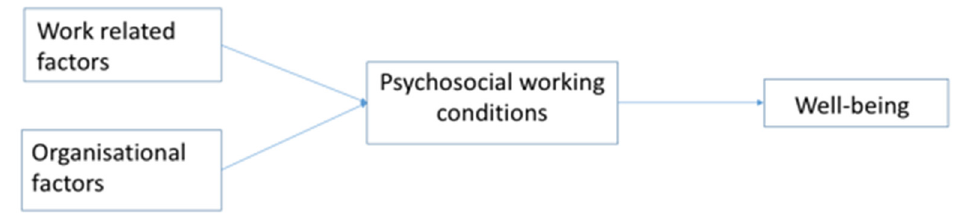
Figure 1. Study conceptual